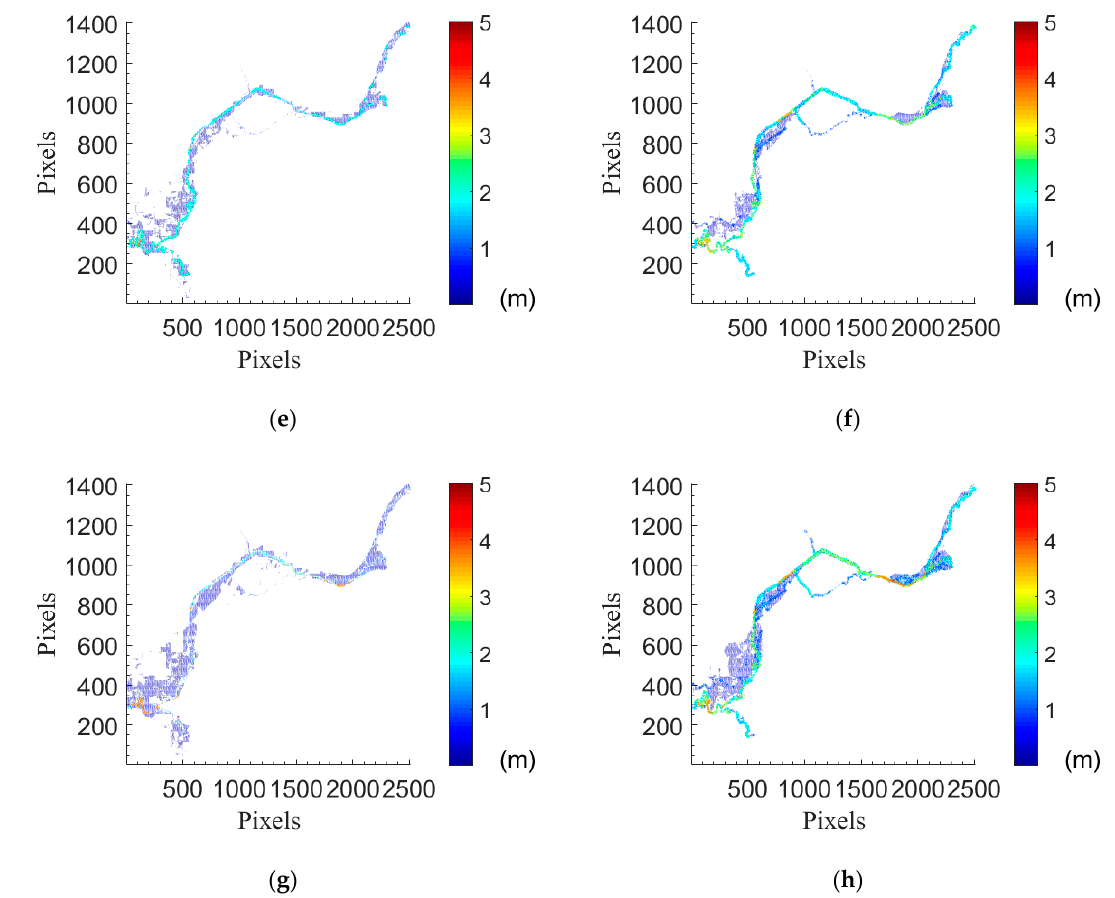
Figure 8. Inundation maps from the prediction of water depths of the first intervals in flood event 2013. ( a ) ANN inundation map 3 h; ( b ) hydrodynamic inundation map 3 h; ( c ) ANN inundation map 6 h; ( d ) hydrodynamic inundation map 6 h; ( e ) ANN inundation map 9 h; ( f ) hydrodynamic inundation map 9 h; ( g ) ANN inundation map 12 h; ( h ) hydrodynamic inundation map 12 h. Table 3. Numbers of wet grids and accurate grid percentages for the flood event in 2013. A wet grid is with the water level over 0.1 m; any water depth below this cutoff value is eliminated. The table shows grid numbers with larger RMSE and their percentages to the total wet grids.